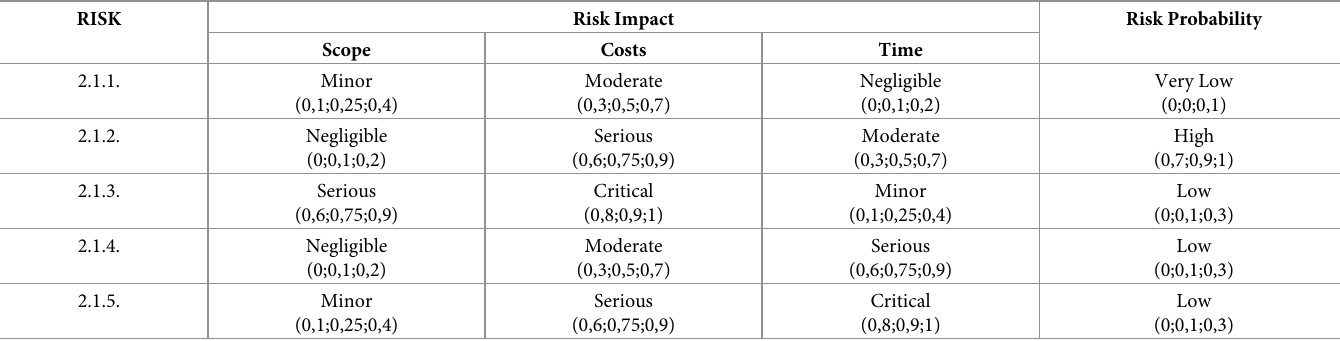
Table 2. RI and RP expert opinions: Sub-group ‘Plant Location’.